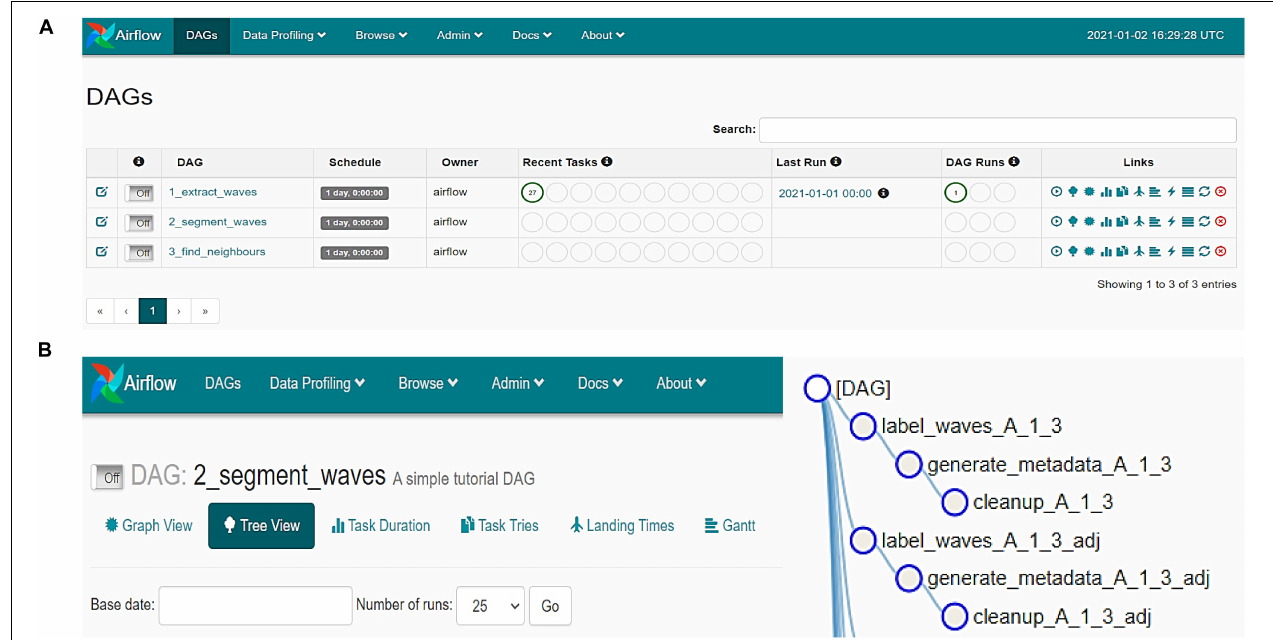
FIGURE 2 | Screen captures demonstrating the Airflow based user interface for the Astral pipeline. (A) General overview of the three processing steps. (B) Tree-view of the sub-tasks.